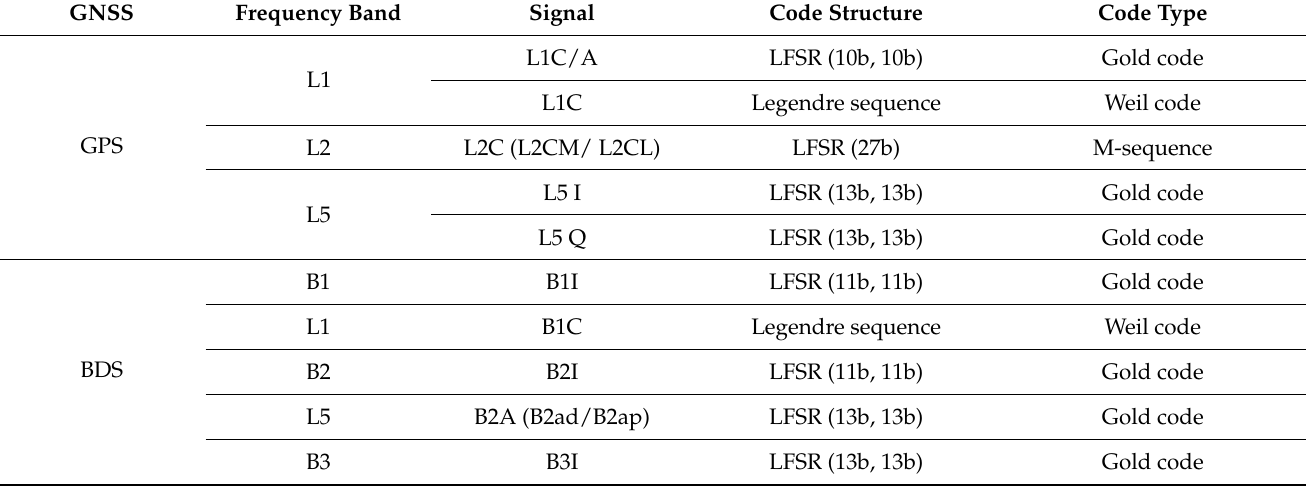
Table 1. Summary the code generation method of GNSS signals